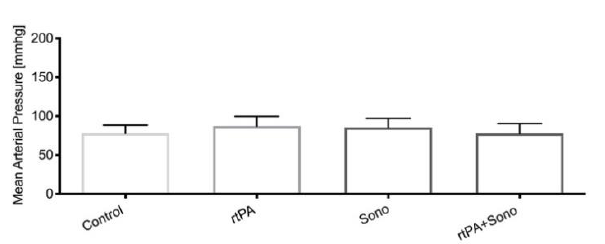
Figure A1. Mean arterial pressure (MAP) of the groups (control Group n = 3; treatment groups (2–4); each n = 6). The means and SD of the MAP are plotted as a column bar graph.